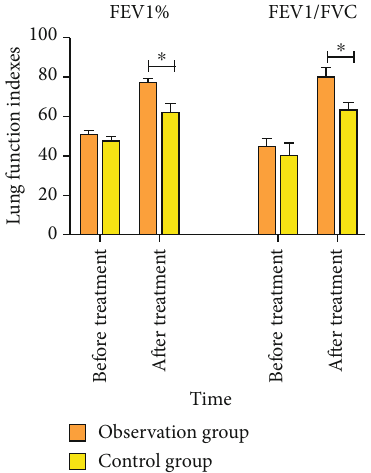
Figure 1: Comparison of lung function indexes between the observation group and the control group before and after treatment through “ t -test ” . Note: compared with the control group, ∗ P < 0 : 05